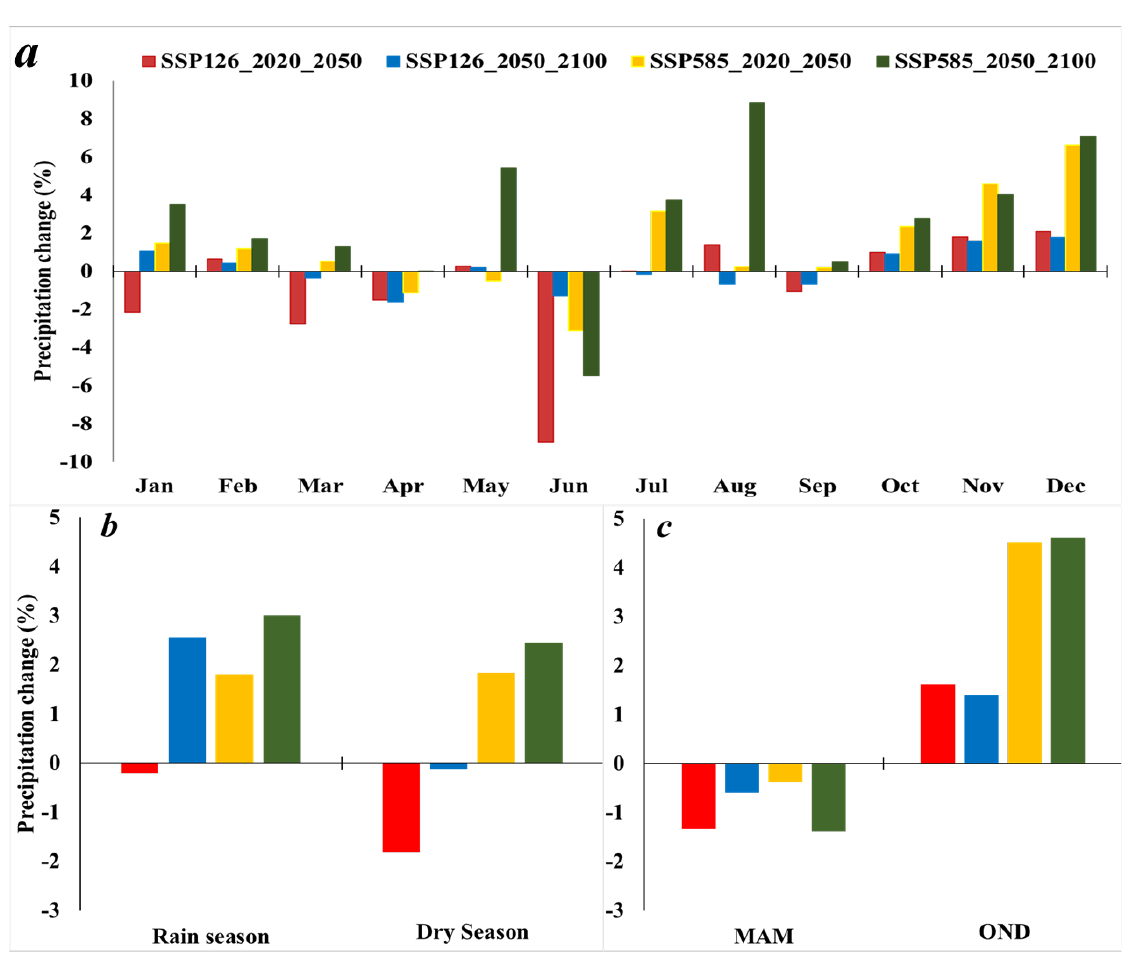
Figure 3. Relative precipitation changes: ( a ) monthly, ( b ) seasonal, and ( c ) in rainy seasons.